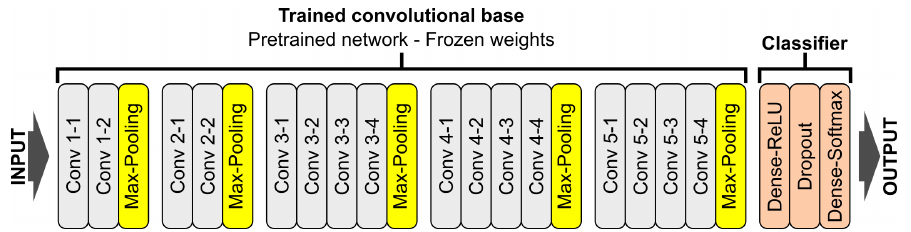
Figure 10. Schematic overview of the personalized VGG-19 network architecture with description of layers.